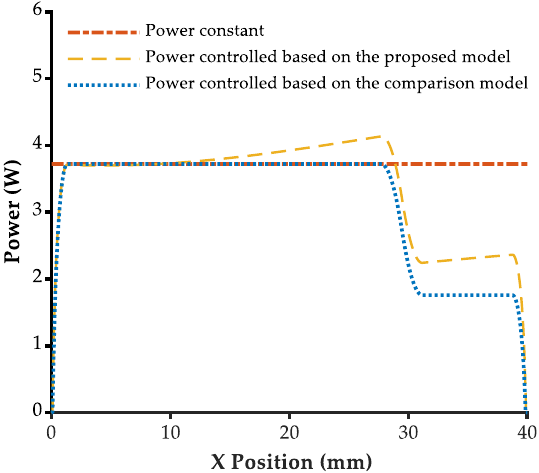
Figure 10. The laser power results controlled by different methods.